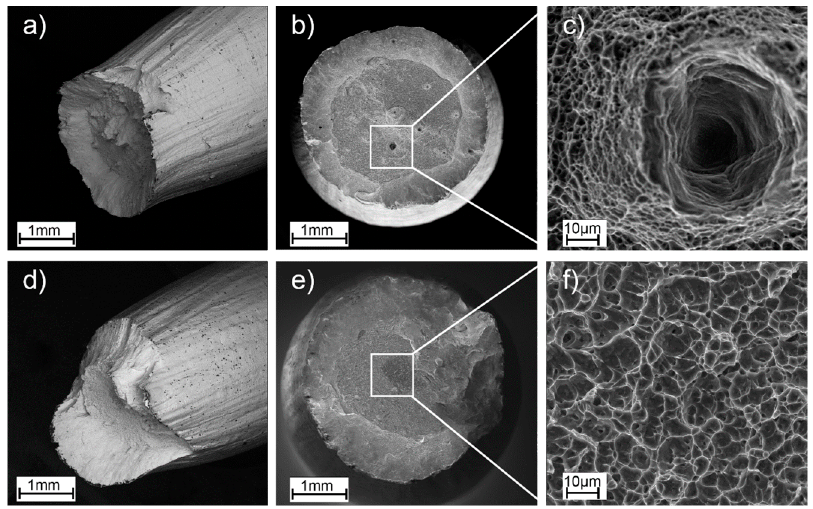
Figure 13. Fracture surfaces of the tensile-fractured specimen, ( a – c ) as-built, and ( d – f ) HIP.